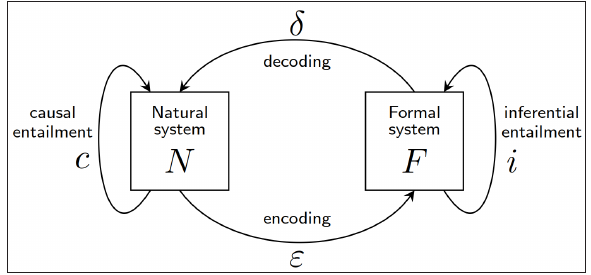
Figure 1: The modelling relation between a natural system N and a formal system F .